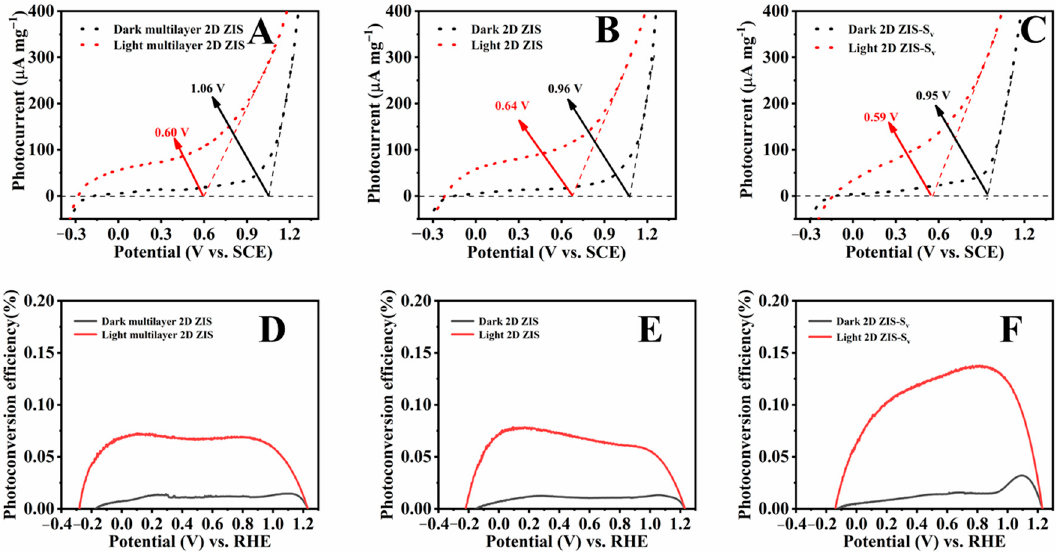
Figure 4. Linear sweep voltammetry curves of multilayer 2D ZIS ( A ), 2D ZIS ( B ), and 2D ZIS ‐ S v ( C ) under light irradiation and in dark; photoconversion efficiency of multilayer 2D ZIS ( D ), 2D ZIS ( E ), and 2D ZIS ‐ S v ( F ) under light irradiation and in dark.